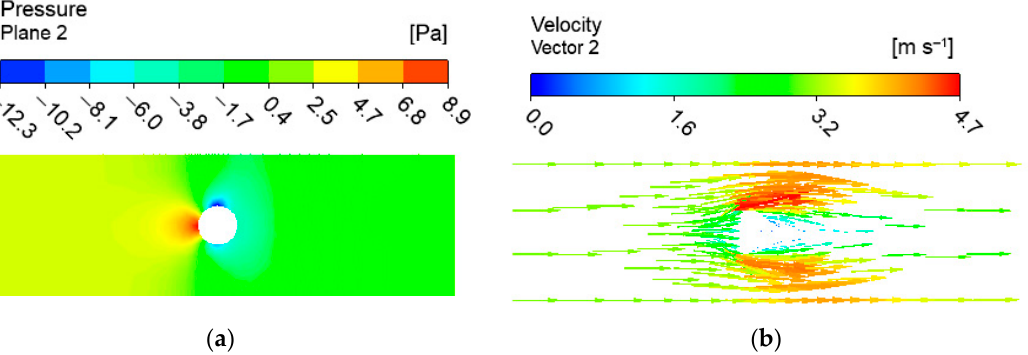
Figure 8. Flow field cloud diagram at z = 100 section position (length 200 mm, air velocity 3 m/s): ( a ) pressure distribution; ( b ) velocity vector distribution.